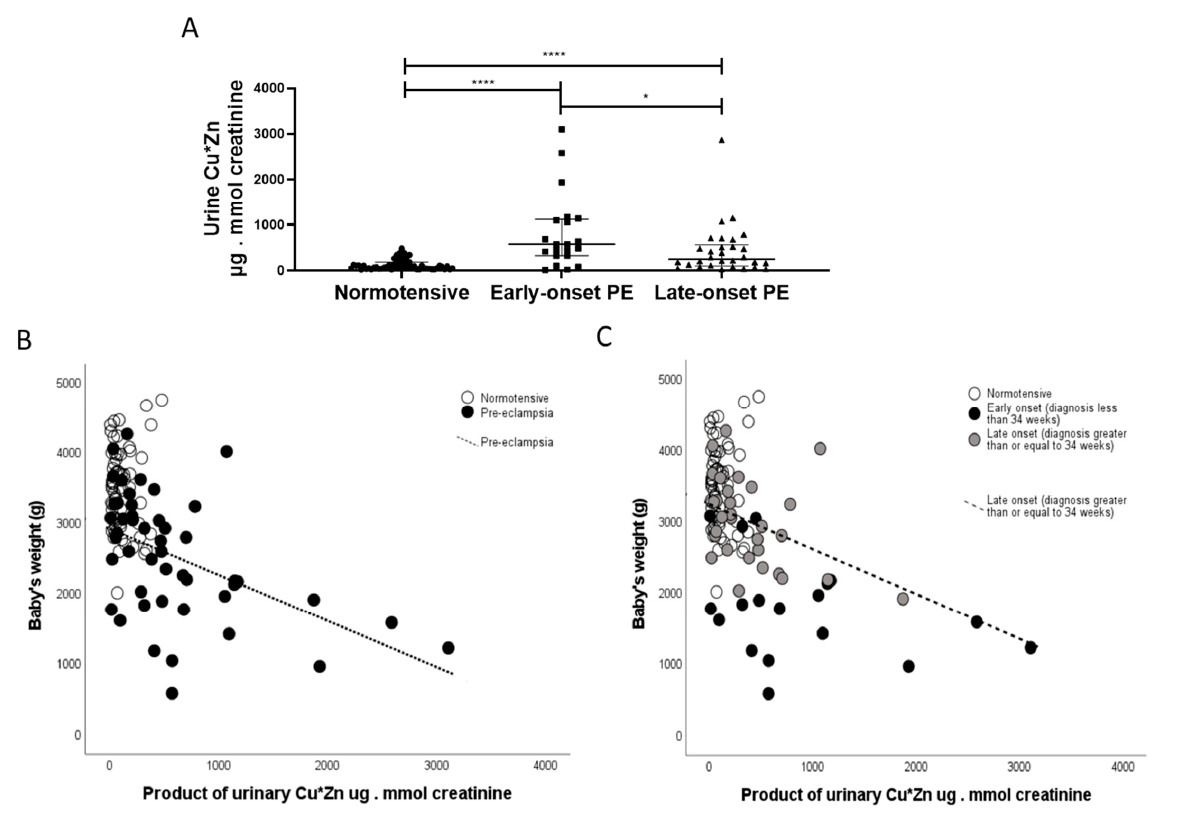
Figure 8 . The product of CuxZn; µg/L in urine were determined in samples from ( A ) normotensive pregnant (n = 60) and women with early- (n = 24) and late-onset (n = 31) pre-eclampsia (PE). Data are presented corrected for urine flow by determination of urine creatinine as median (IQR); * p < 0.05; **** p < 0.0001. Scatter plots of CuxZn with ( B ) with birthweight in pre-eclampsia samples (r = − 4.70; p < 0.0001; dotted line) and ( C ) when spilt by early-/late-onset pre-eclampsia, the negative trends were seen only in the late-onset pre-eclampsia group (r = − 4.50; p = 0.01; hashed line).